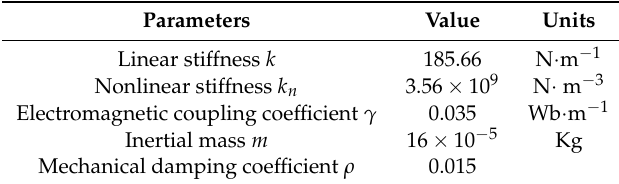
Table 1. Parameters of the nonlinear electromagnetic energy harvester proposed by Mallick et al.